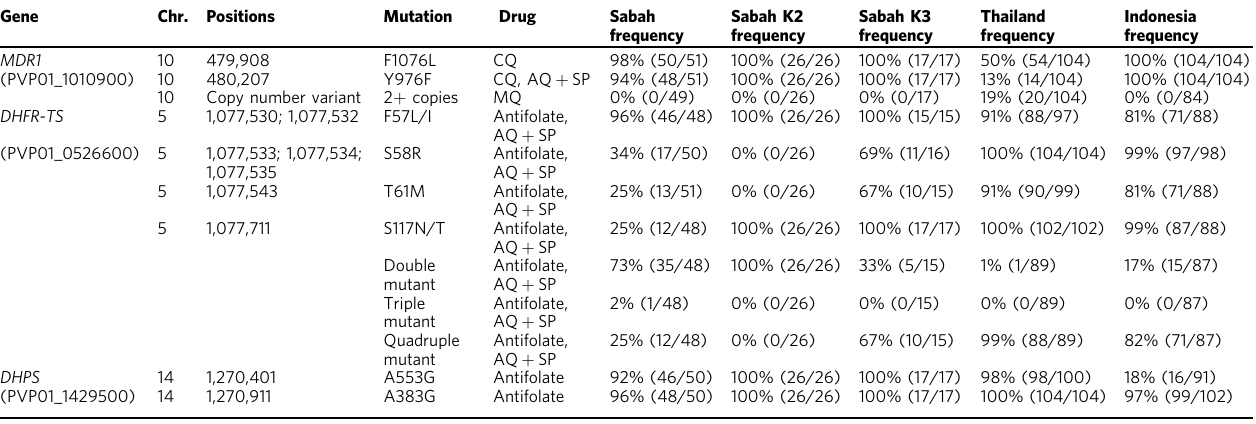
Table 1 Prevalence of variants that have previously been associated with P. vivax drug resistance Chr.